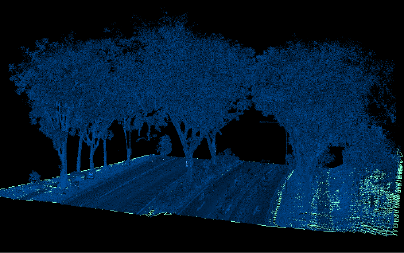
Figure 5. TIN ground